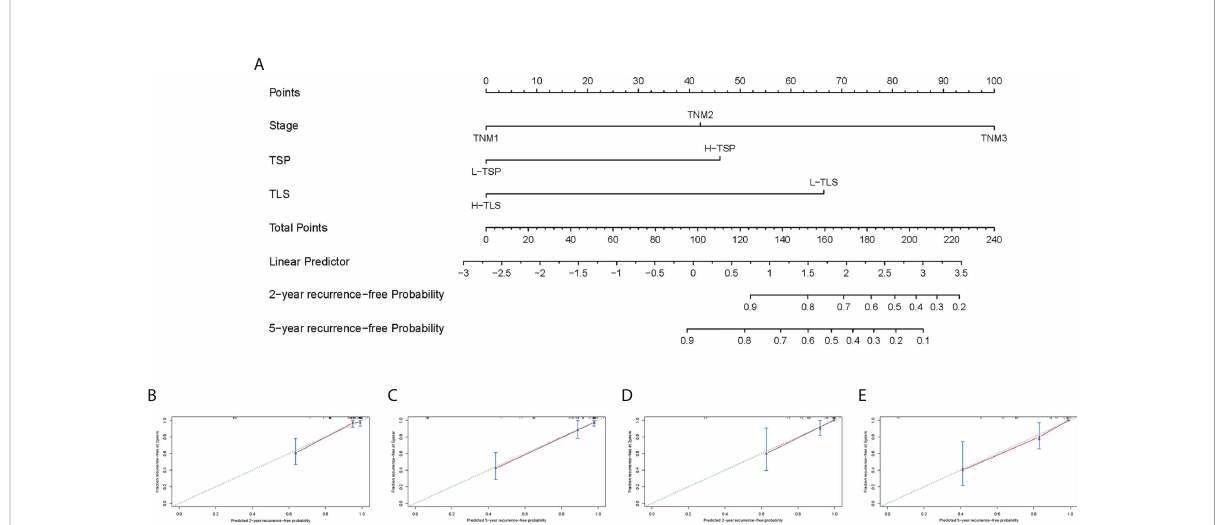
FIGURE 6 Nomogram predicts RFS and the calibration curves of the Nomogram predict RFS. (A) Nomogram was developed based on three factors: TNM stage, TLS and TSP to predict the probability of RFS at 2- and 5-years. The probabilities might be estimated as the sum of points for each variable as a function of total points. Each component was allocated points by drawing a line upward from the matching values to the ‘ point ’ line. On the “ total points ” line, the total sum of points added by each variable was shown. A line was drawn downward to read the associated probability forecasts. The Bootstrap method was used for internal validation, with 1000 repeat samples. Calibration curves of a nomogram to predict RFS at 2- and 5-years in the training set (B, C) and external validation set (D, E)